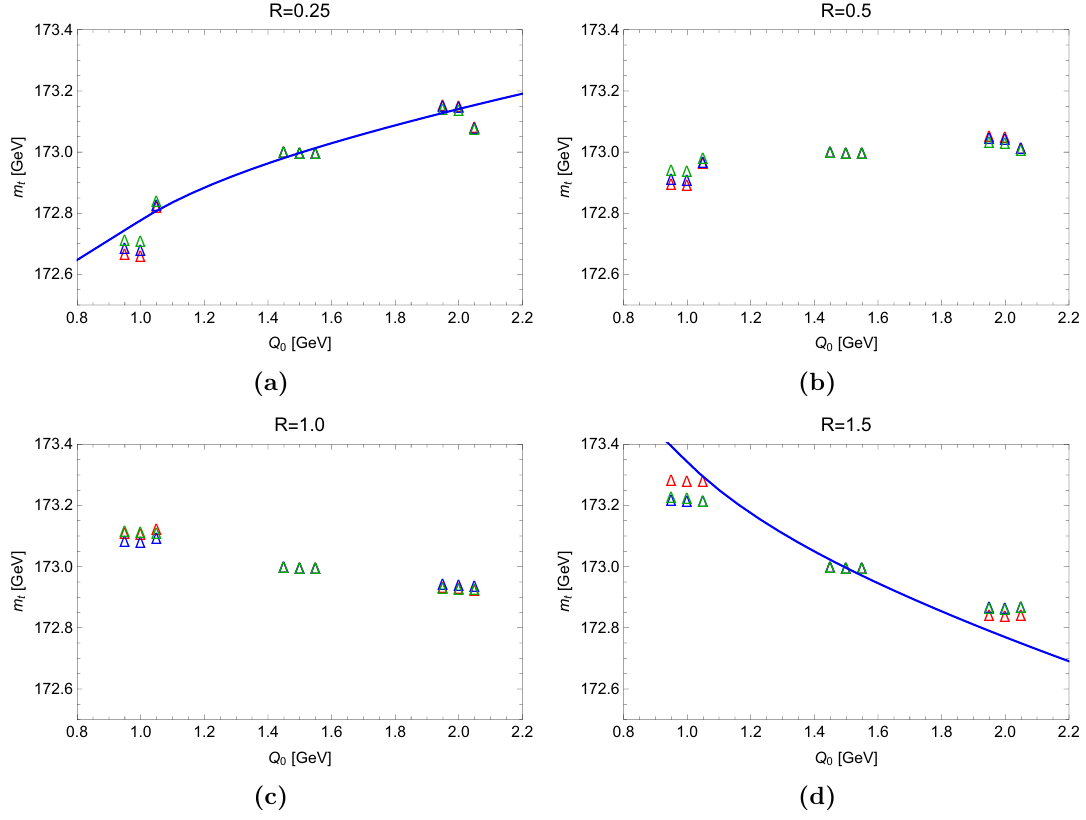
Figure 21. Fitted top quark mass obtained from the m b resonance region for shower cut values j W Q 0 = Q 0 ;b = 1 : 0, 1 : 5 and 2 : 0 GeV for Q = 700 GeV using the k t -type algorithm (green), the Cambridge-Aachen algorithm (blue) and the anti- k t -type algorithm (red) for b -jet clustering. For each Q 0 value the respective left set of symbols come from the LO simulations, the respective middle set of symbols come from simulations with MC@NLO-type matching and the respective right set of symbols from simulations with POWHEG-type matching. Displayed are the results for b -jet radii R = 0 : 25, 0 : 5, 1 : 0 and 1 : 5. The solid blue line in the lower right panel corresponds to eq. (7.5) and the one in the upper left panel corresponds to eq. (7.6) using Q 0 = 1 : 5 as the reference 0